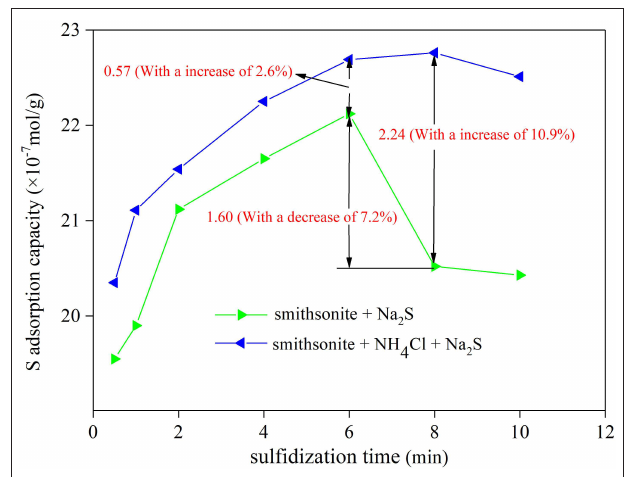
FIGURE 2 | S adsorption capacity of smithsonite surface with sulfidization